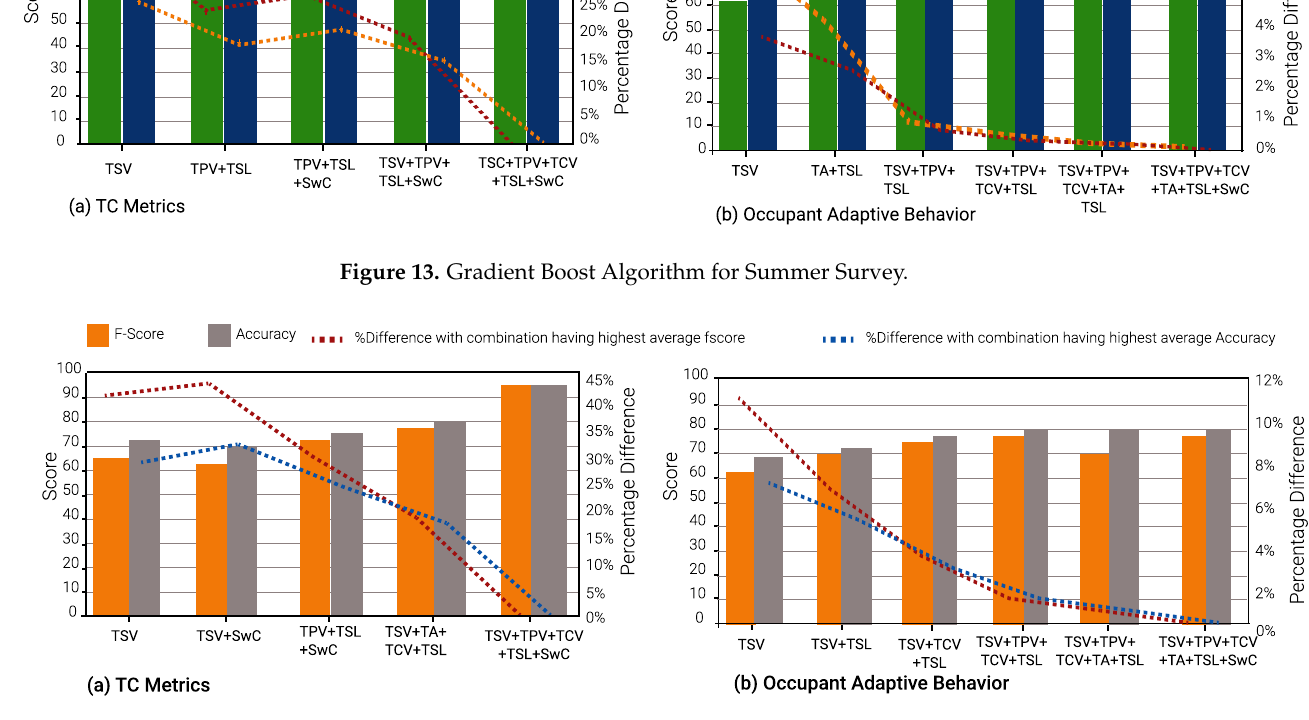
Figure 14. Random Forest Algorithm for Summer Survey.